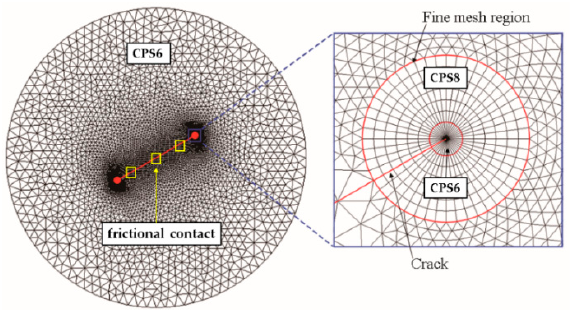
Figure 5. Numerical model of a central crack Brazilian disc. Table 1. CCBD model parameters for